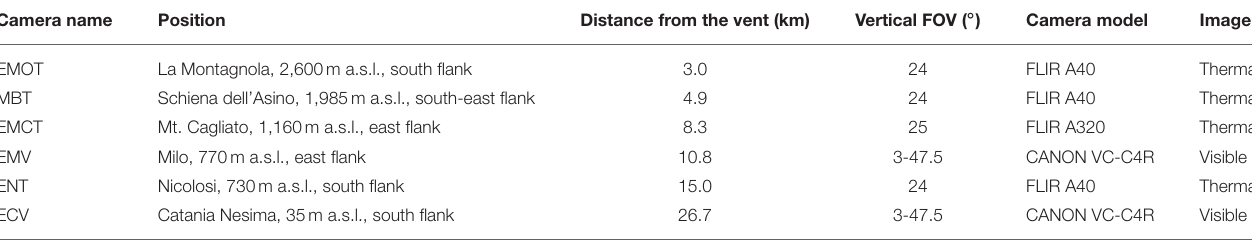
TABLE 2 | Characteristics of visual and thermal cameras of the INGV-OE monitoring network used in this paper. Camera